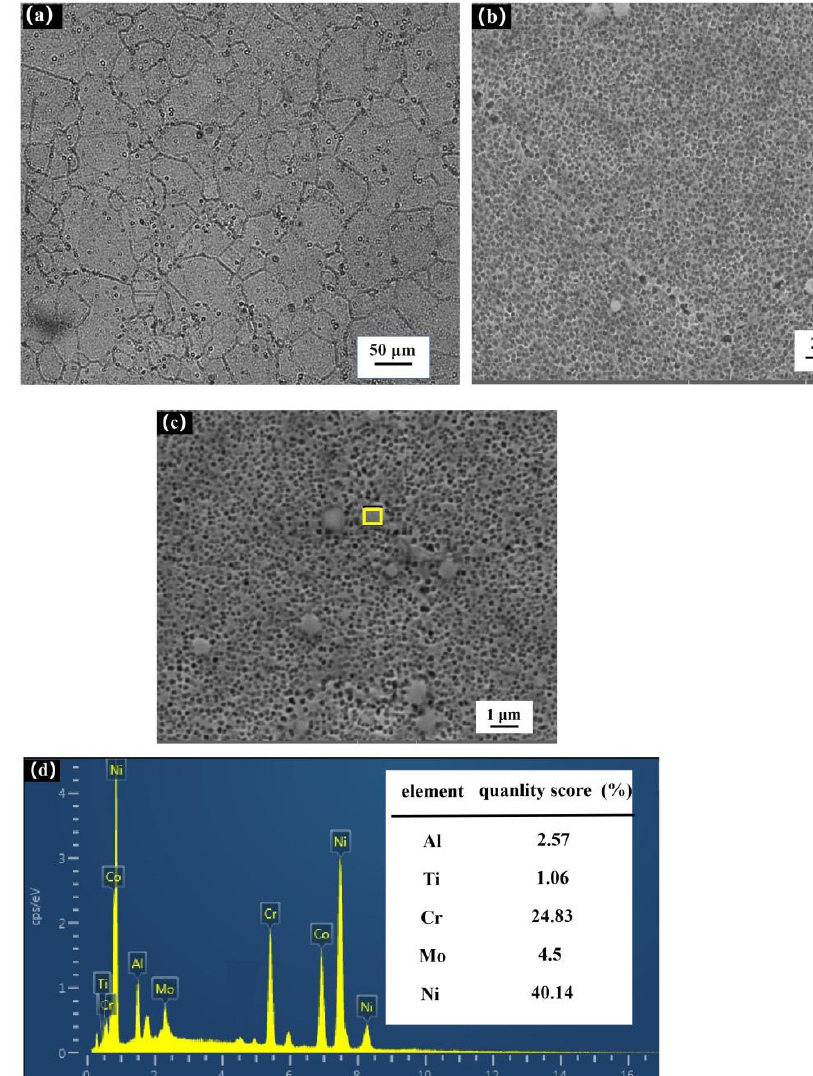
Figure 3. Microstructure of FGH96 alloy: ( a ) light microscope structure, ( b ) primary γ′ phase and secondary γ′ phase, ( c ) carbide M 23 C 6 , ( d ) EDS analysis results.